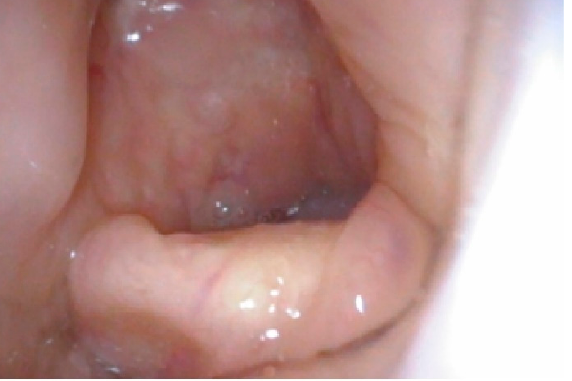
Figure 3. Nasendoscopy picture of MPS II showing a high and anterior larynx, epiglottis is touching the soft palate, vallecula is not seen, and only posterior pharyngeal wall is seen.